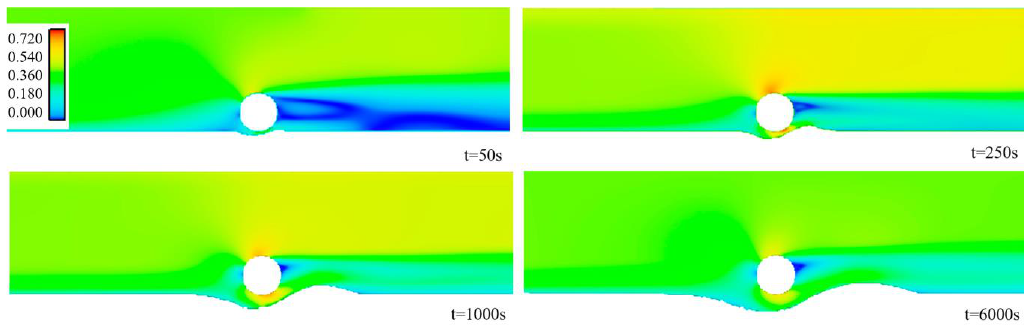
Figure 7. The velocity change in scour processes.